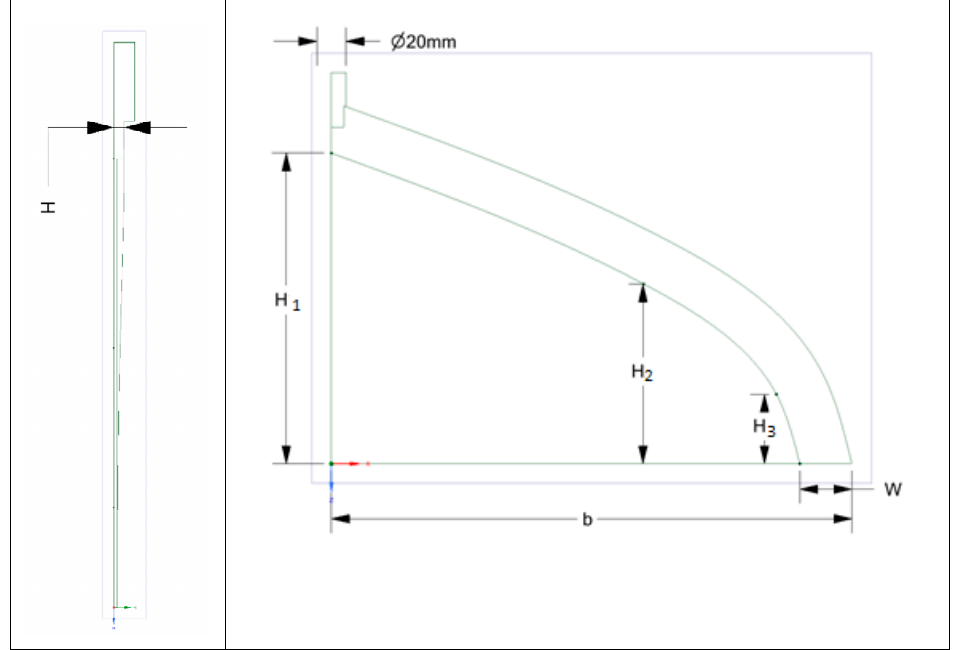
Figure 1. Schematic of the extrusion die in this analysis.